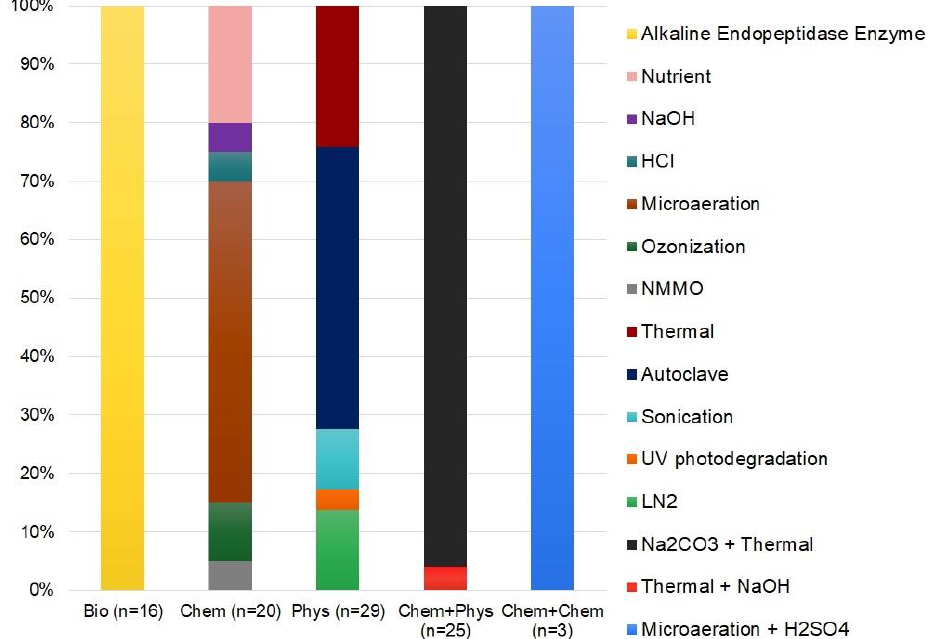
Figure 2. Diversity of methods composing the pretreatment categories applied to improve AD of textile waste reported in articles included in the meta-analysis. Biological: alkaline endopeptidase ( n = 16); chemical: nutrient ( n = 4), NaOH ( n = 1), HCl ( n = 1), microaeration ( n = 11), ozonization ( n = 2), N-methylmorpholine N-oxide (NMMO) ( n = 1); physical : thermal ( n = 7), autoclave ( n = 14), sonication ( n = 3), UV photodegradation ( n = 1), liquid nitrogen (LN 2 ) ( n = 4); chemical + physical: Na 2 CO 3 + thermal ( n = 24), thermal + NaOH ( n = 1); chemical + chemical: microaeration + H 2 SO 4 ( n = 3).